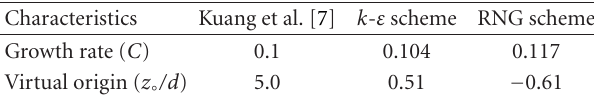
Table 1: Growth rate and virtual origin